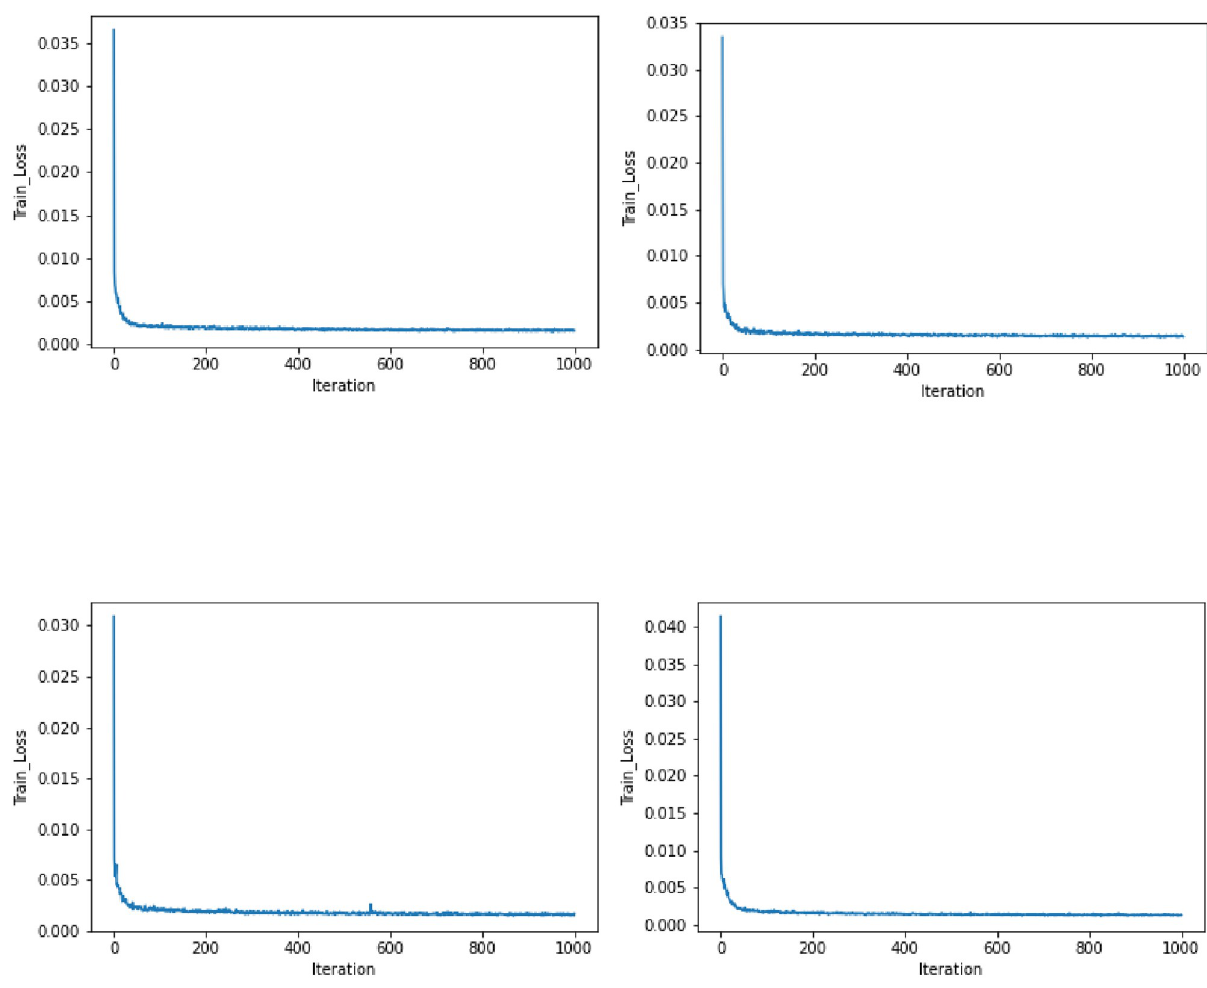
Fig 8. Loss function error rate. (a) HBL Bank. (b) NBP Bank. (c) UBL Bank. (d) Bank